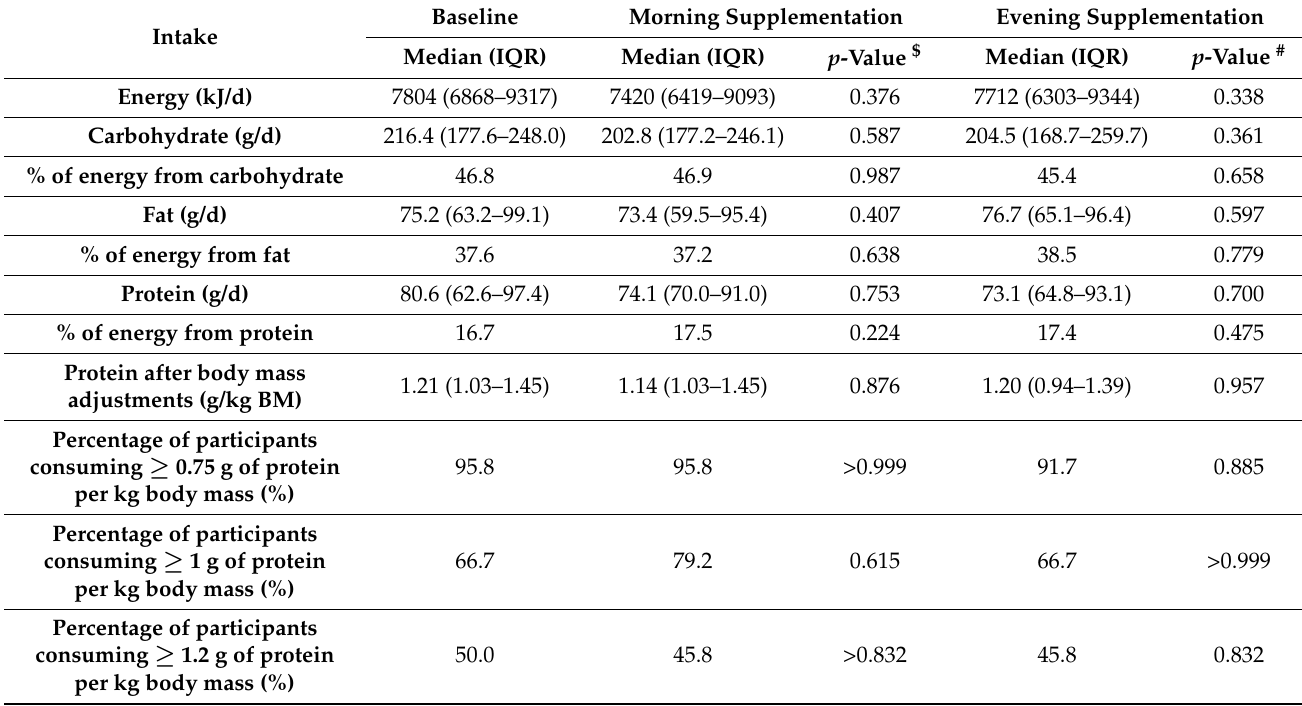
Table 2. Median (IQR) energy and macronutrient intakes of all participants across the different phases of the